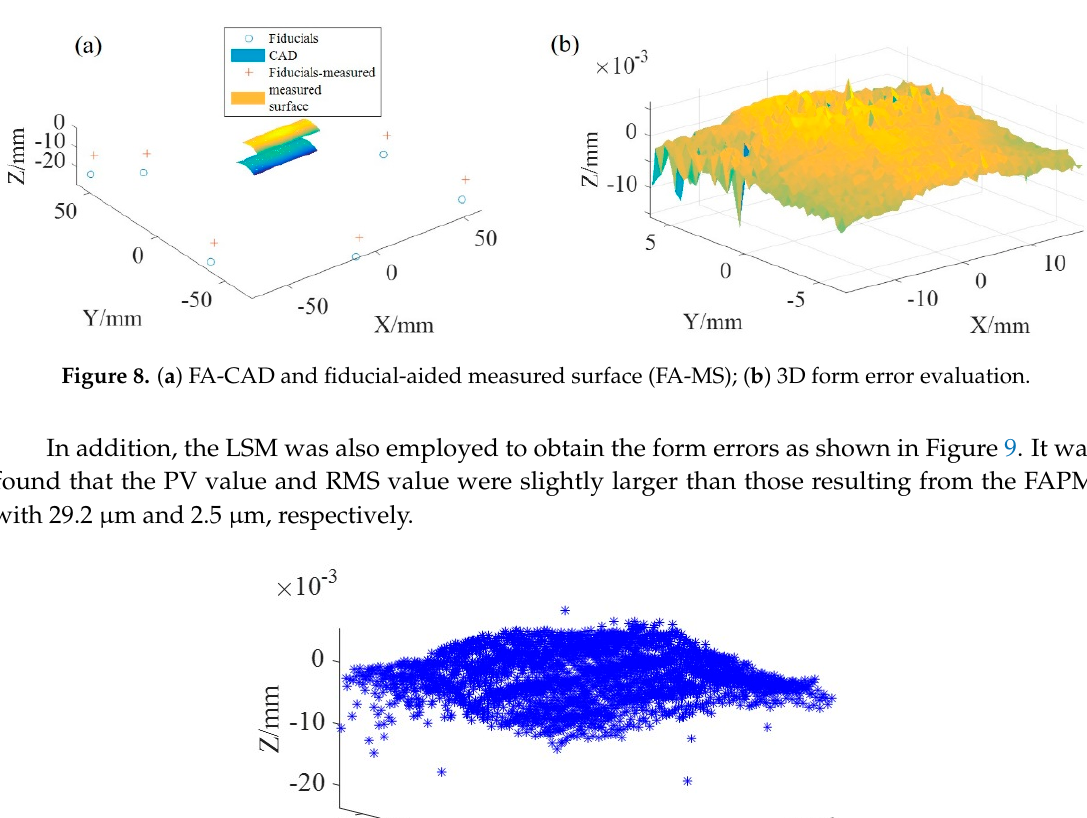
Figure 7. Measurement on a coordinate measuring machine (CMM) machine.